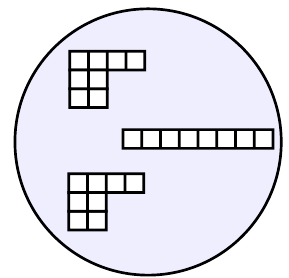
Figure 6 . An interacting fixture in the D 4 theory realizing the doubled rank-1 E 6 Minahan- Nemeschansky